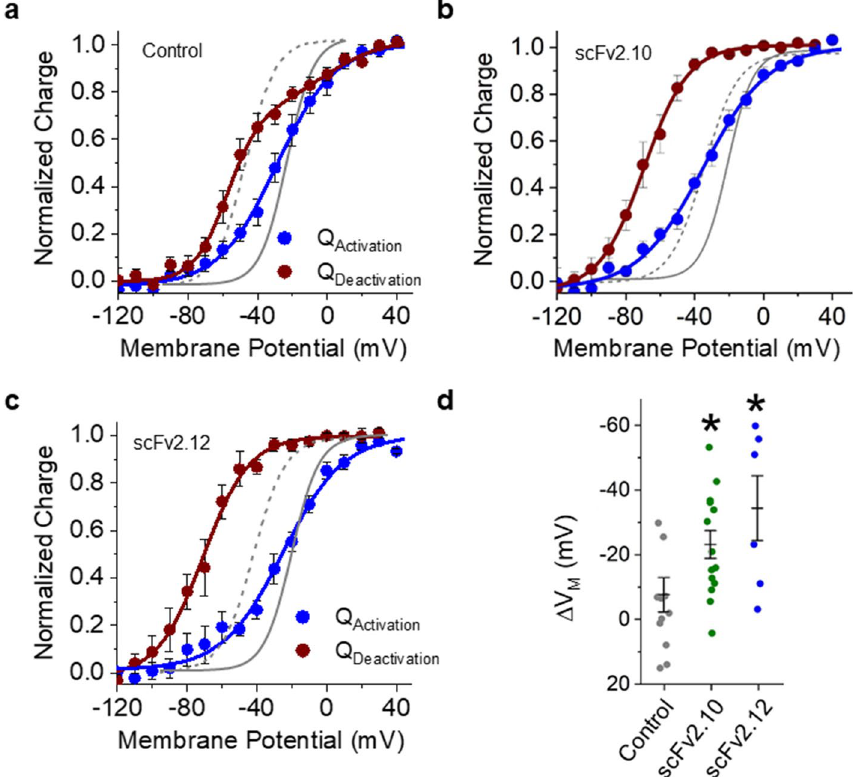
Figure 7. Anti-PAS antibodies enhance VSD hysteresis. (a-c) Voltage dependence of hERG 1a voltage sensor activation (blue) and deactivation (red) for vehicle controls ( a ), scFv2.10 ( b ), and scFv2.12 ( c ). Fits from ionic currents are shown in gray. Gating currents elicited during the test pulse were integrated, and the resultant gating charge was normalized, plotted as a function of test potential and fitted with a Boltzmann function. ( d ) The magnitude of hysteresis was quantified by subtracting the V median of deactivation from the V median of activation. Hysteresis was significantly larger in the presence of scFv2.10 ( n = 14) or the presence of scFv2.12 ( n = 6) compared with vehicle control recordings ( n = 12). All data are reported as mean ± SEM. * indicates p <